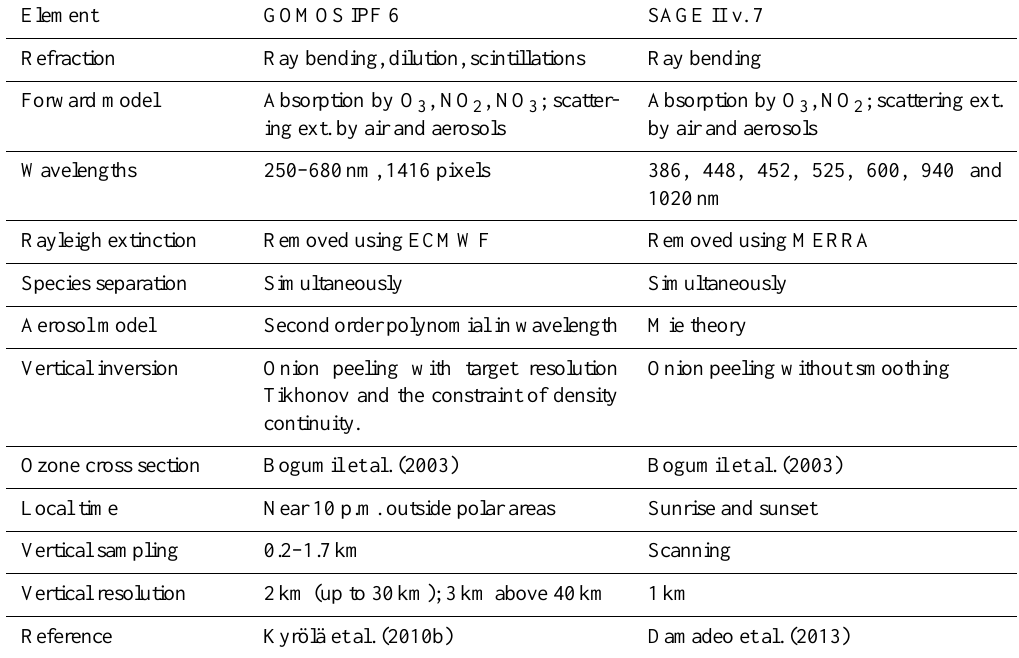
Table 1. SAGE II and GOMOS (UV-Vis) retrieval